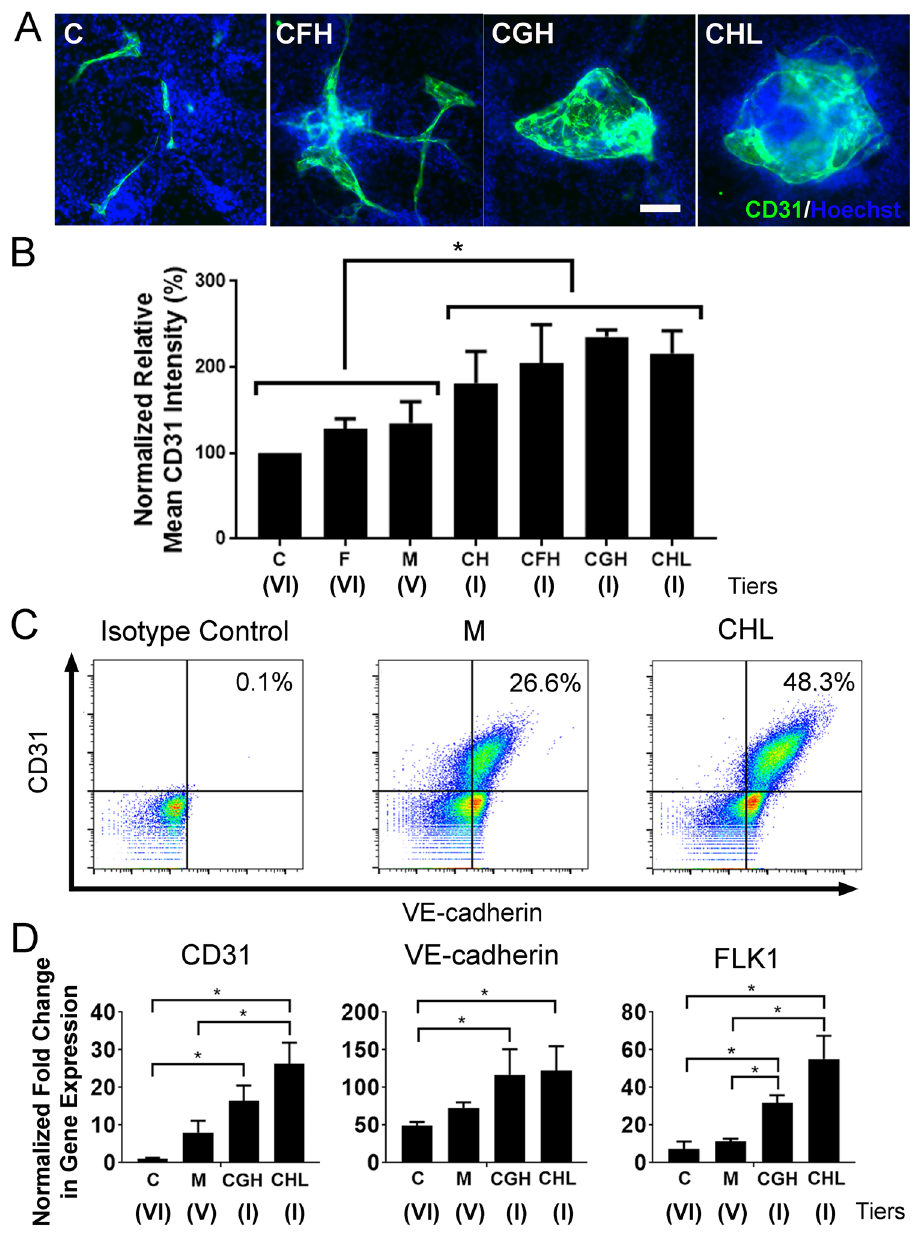
Figure 2. Conventional cell culture platform validates the effect of combinatorial ECMs on endothelial differentiation. ( A ) Representative confocal images of differentiated ESCs (H1) after 5 days of differentiation. Endothelial differentiation based on CD31 expression was assessed on chamber slides pre-coated with representative combinatorial or single-factor ECMs: CHL (Tier I); CGH (Tier I); CFH (Tier I); CH (Tier I); M (Tier V); F (Tier VI) and C (Tier VI). Green: CD31, Blue: Hoechst 33342. There was a significant increase in the amount of CD31 expression in Tier I multi-component ECMs such as CHL and CGH, compared to single-factor ECMs like F and C in Tier VI. ( B ) Quantification of normalized CD31 protein intensity shows a significant increase in CD31 expression between single-component ECMs from Tier VI and multi-component ECMs in Tier I (n ≥ 6). ( C ) Characterization of ESC (H1) differentiation efficiency by FACS. The CD31 + / VE-cadherin + cell population on Tier I CHL-coated plates (48.3%) was higher than that on Tier V M-coated plates (26.6%). ( D ) Quantitative PCR shows significant increase in gene expression of CD31, VE-cadherin and FLK1 when ESCs underwent endothelial differentiation on Tier I ECM combinations CHL and CGH (n = 3). * Denotes P <